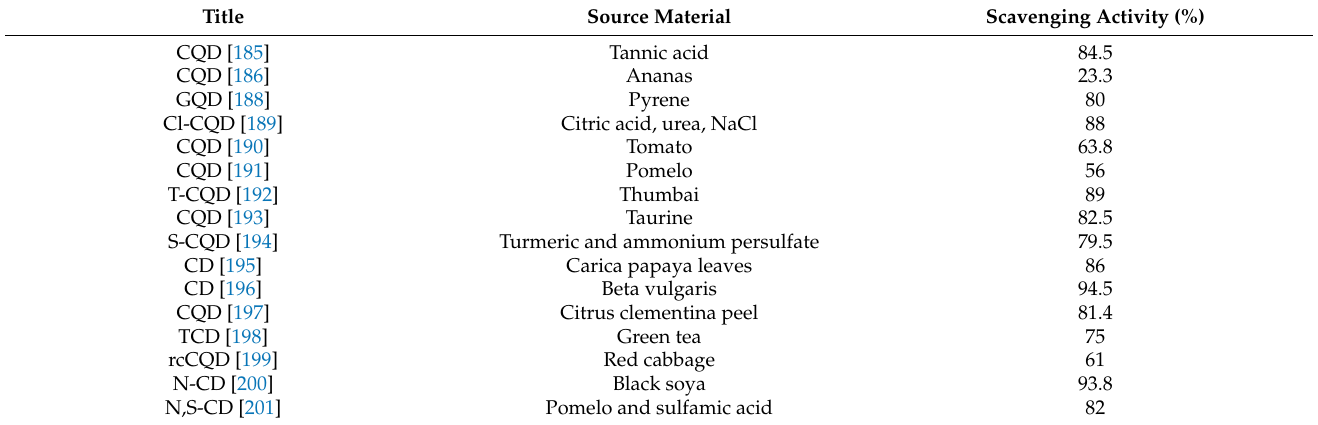
Table 3. Values of DPPH scavenging activities for selected CDs.